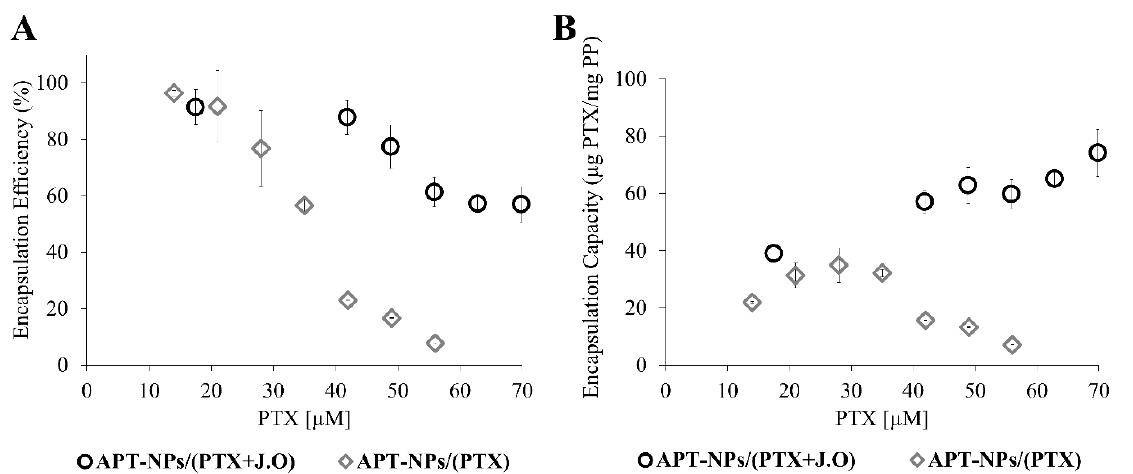
Figure 4. ( A ) Encapsulation efficiency (EE); ( B ) encapsulation capacity (EC) of PTX as a function of PTX concentration in the presence or absence of JO. Values presented are means ± SE.